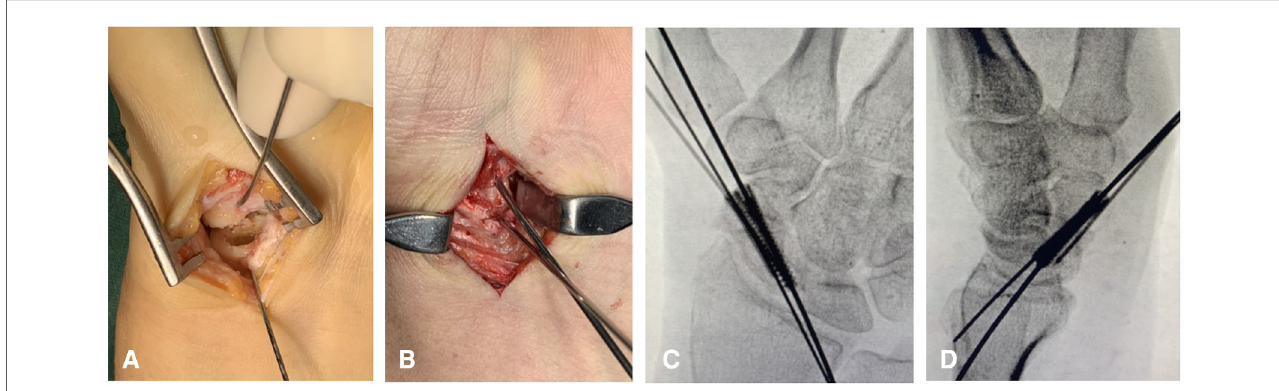
FIGURE 2 Fibrous tissue fragments were thoroughly debrided, leaving a shell of intact cartilage ( A ). Cancellous graft obtained from the patients ’ iliac crest was impacted into the shell, and a wedge-shaped corticocancellous graft was inserted into the defect to maintain the reduction. Kirschner wires were used as joysticks to distract across the nonunion site ( B ). Two cannulated screws were inserted into the scaphoid along the guide wires, and the length and position of the screws were con fi rmed by x-ray ( C, D